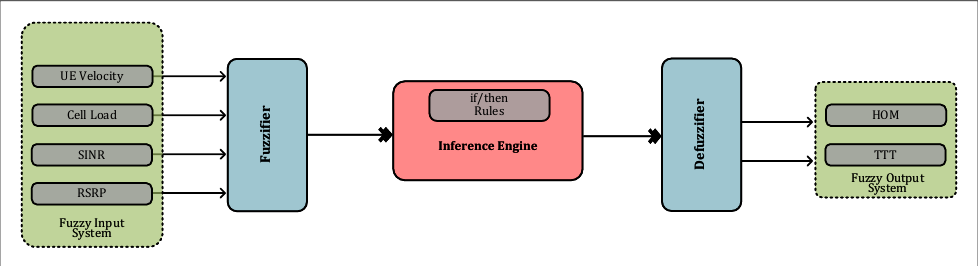
Figure 8. Schemetic Diagram of Fuzzy Logic-based Handovers in HetNets. Table 6. Summary of RSRP-based Handover